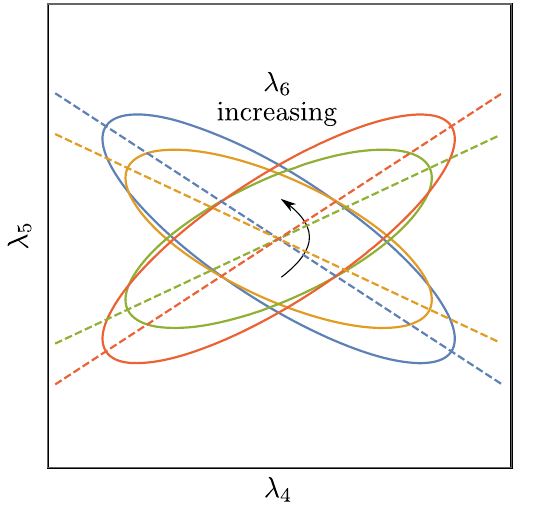
= 3, the usual values for the VEVs and m λ 3 how the conics rotate counter clockwise as λ 6 increases, c.f. Eq. (43)